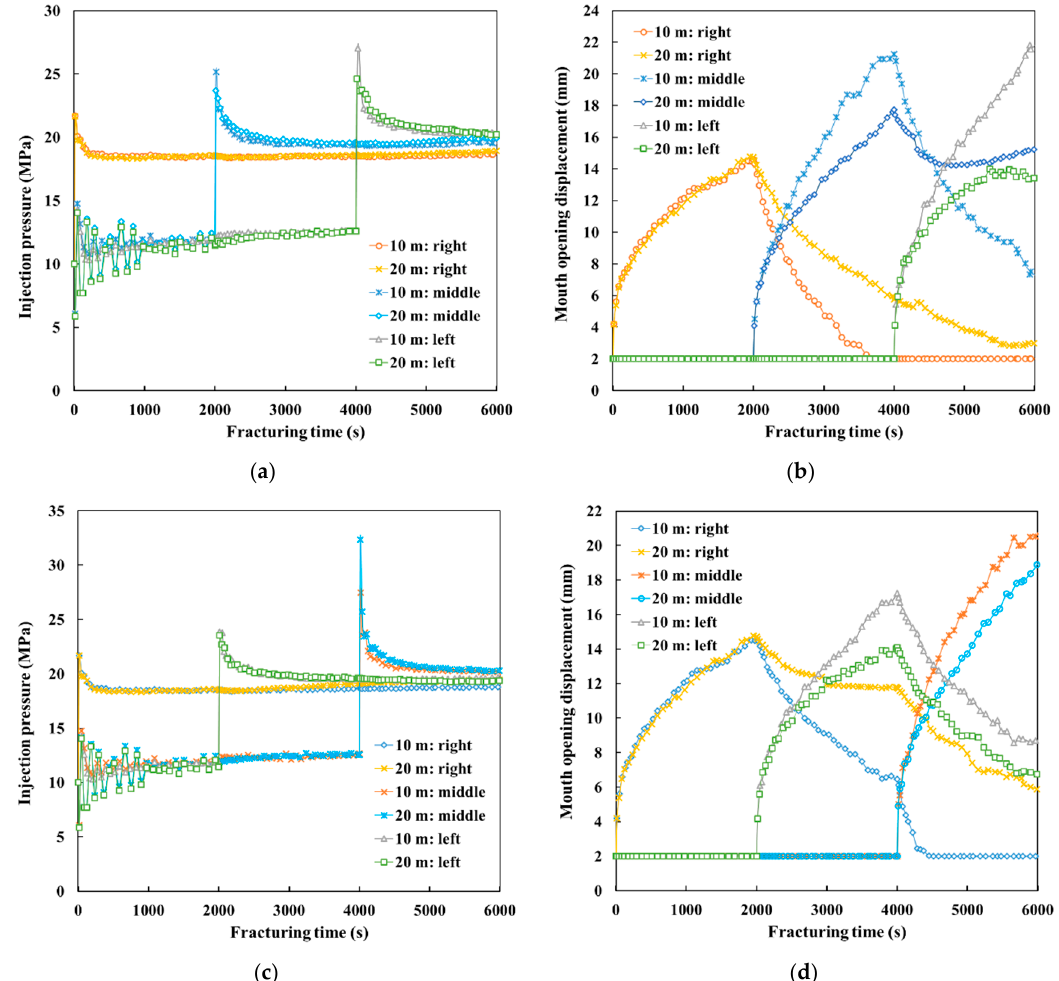
Figure 12. Variation of injection pressure and mouth opening displacement with different closely-spacing sequential and alternative sequential fracturing: ( a ) Variation of injection pressure with sequential fracturing; ( b ) Variation of mouth opening displacement with sequential fracturing; ( c ) Variation of injection pressure with alternative sequential fracturing; ( d ) Variation of mouth opening displacement with alternative sequential fracturing.